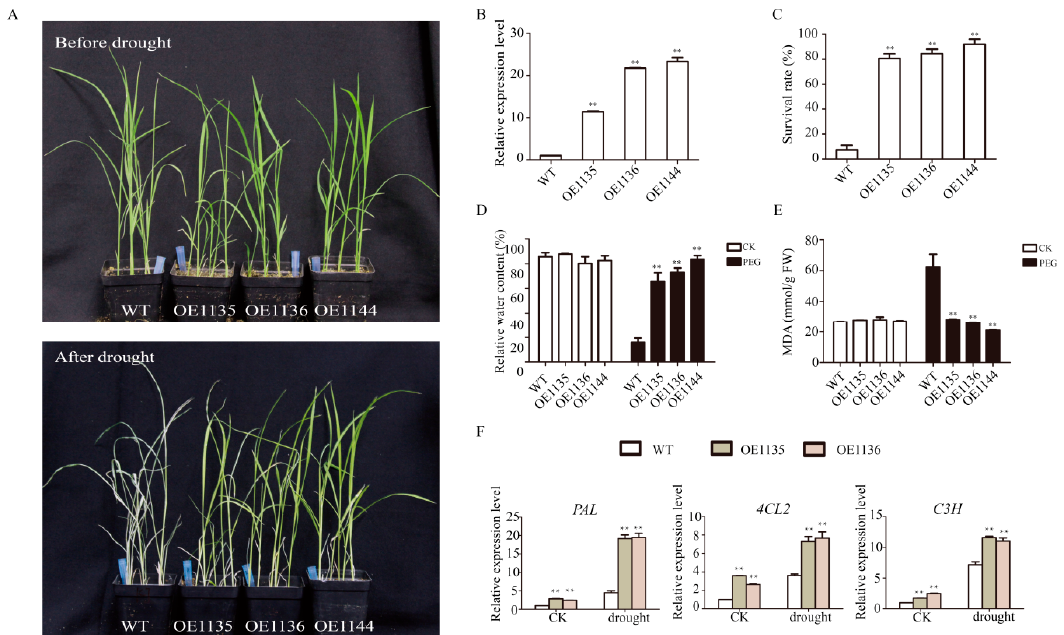
Figure 5. Phenotypic analysis of transgenic and control rice seedlings under drought stress. ( A ) Growth of transgenic and control rice seedlings under normal conditions and after drought treatment for 12 days. ( B ) The expression level of the SiWLIM2b gene in transgenic rice lines was determined by qRT-PCR. ( C ) The survival rates of control rice and transgenic rice lines after drought treatment. ( D ) The relative water contents of the control and transgenic rice lines under normal growth conditions and after drought treatment. ( E ) The MDA contents of the control and transgenic rice lines under normal growth conditions and after drought treatment. ( F ) The expression of genes related to the phenylpropane secondary metabolic pathway normal growth (CK) and after drought treatment. Vertical bars in ( B – F ) indicate ±SE of three replicates. **indicates significant differences in comparison with the control lines at p < 0.01. *indicates significant differences in comparison with the control lines at p < 0.05.